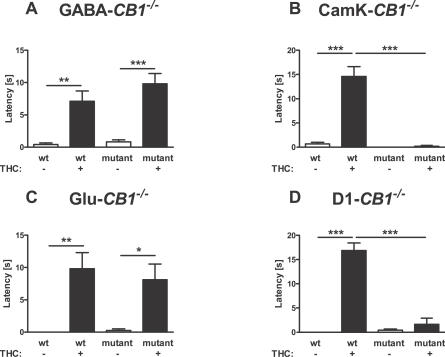
Cataleptic Effect of THC in Different CB1 Mutant MiceLatency of descent of the forepaws from a horizontal bar was recorded for 20 s, 90 minutes after the injection of 10 mg/kg THC or vehicle. *, **, ***; p < 0.05, p < 0.01, p < 0.001, respectively (two-way ANOVA, followed by Newman-Keuls post-hoc test). The effect is preserved in GABA-CB1
−/− (A) and Glu-CB1
−/− mice (C), but almost completely abolished in CaMK-CB1
−/− (B) and D1-CB1
−/− mice (D). See Materials and Methods for number of animals in each group.